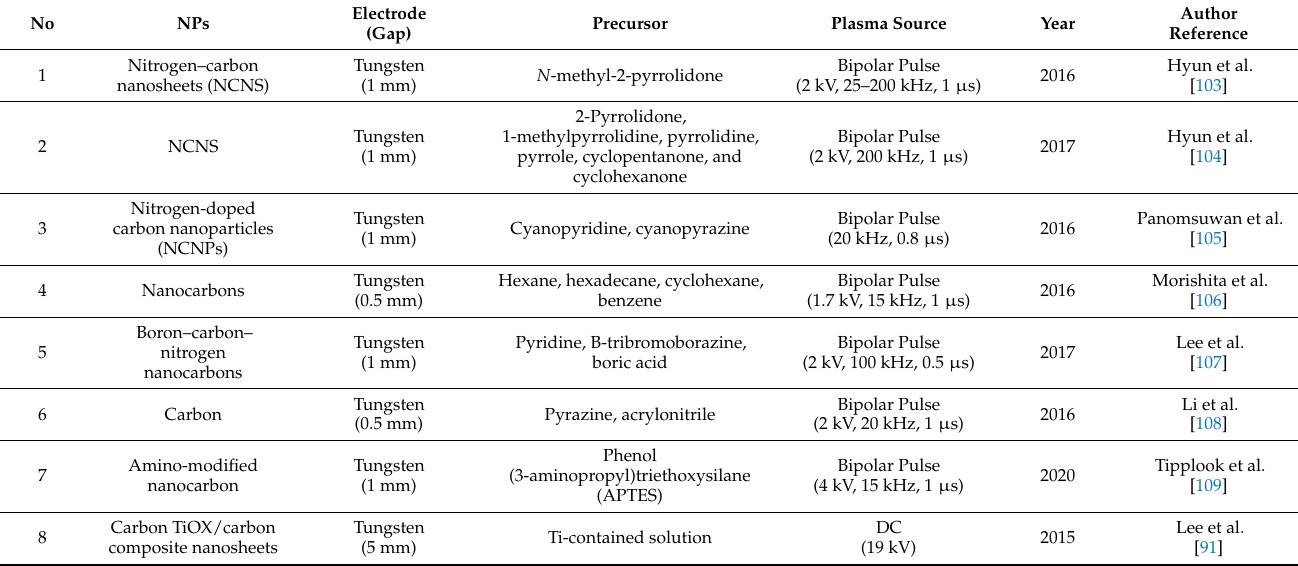
Figure 13. Schematic diagrams of the in-solution plasma system with a gas channel proposed by ( a,b ) Shin et al. [111,112]. Table 4. Summary of syntheses using in-solution plasma